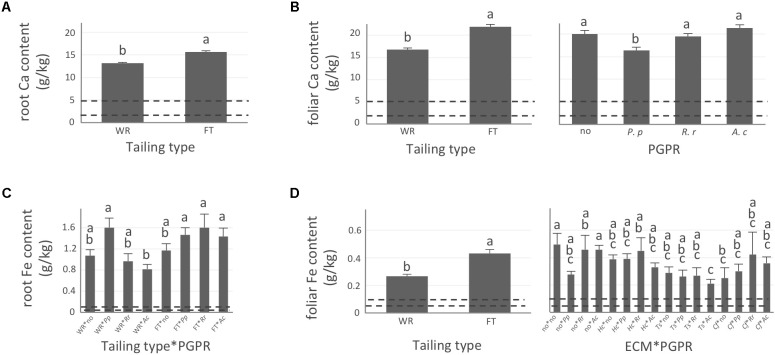
Calcium and iron concentrations of white spruce roots and needles. White spruce seedlings were grown for 32 weeks on waste rocks (WT) or fine tailings (FT) with or without mycorrhizal fungi inoculation (noF = no fungus, +Hc = Hebeloma crustuliniforme, +Ts = Tricholoma scalpturatum, and +Cf = Cadophora finlandia) and with or without inoculation of rhizobacteria (noB = no bacteria, +Pp = Pseudomonas putida, +Rr = Rhizobium radiobacter, and +Ac = Azotobacter chroococcum). (A) Root calcium (Ca) content (g/kg) was affected by tailing type treatment (p-value < 0.0001); (B) Foliar Ca concentration was independently affected by tailing type and by bacterial association (p-values < 0.0001); (C) for root iron (Fe) concentration (g/kg), there was an interaction between the two factors “Tailing type x bacteria” (p-value = 0.0206); (D) Foliar Fe concentration was affected by tailing type treatment (p-value < 0.0001), there was an interaction between the two factors “fungi × bacteria” (p-value = 0.0472). Dotted lines indicate optimal concentration ranges (Van den Driessche, 1991). Values are means ± SE. Different letters indicate significant difference.